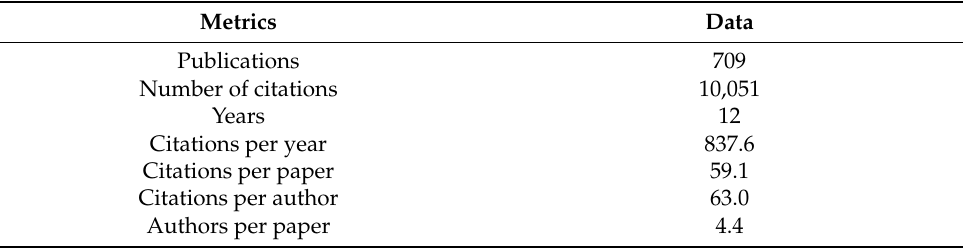
Table 3. Citations